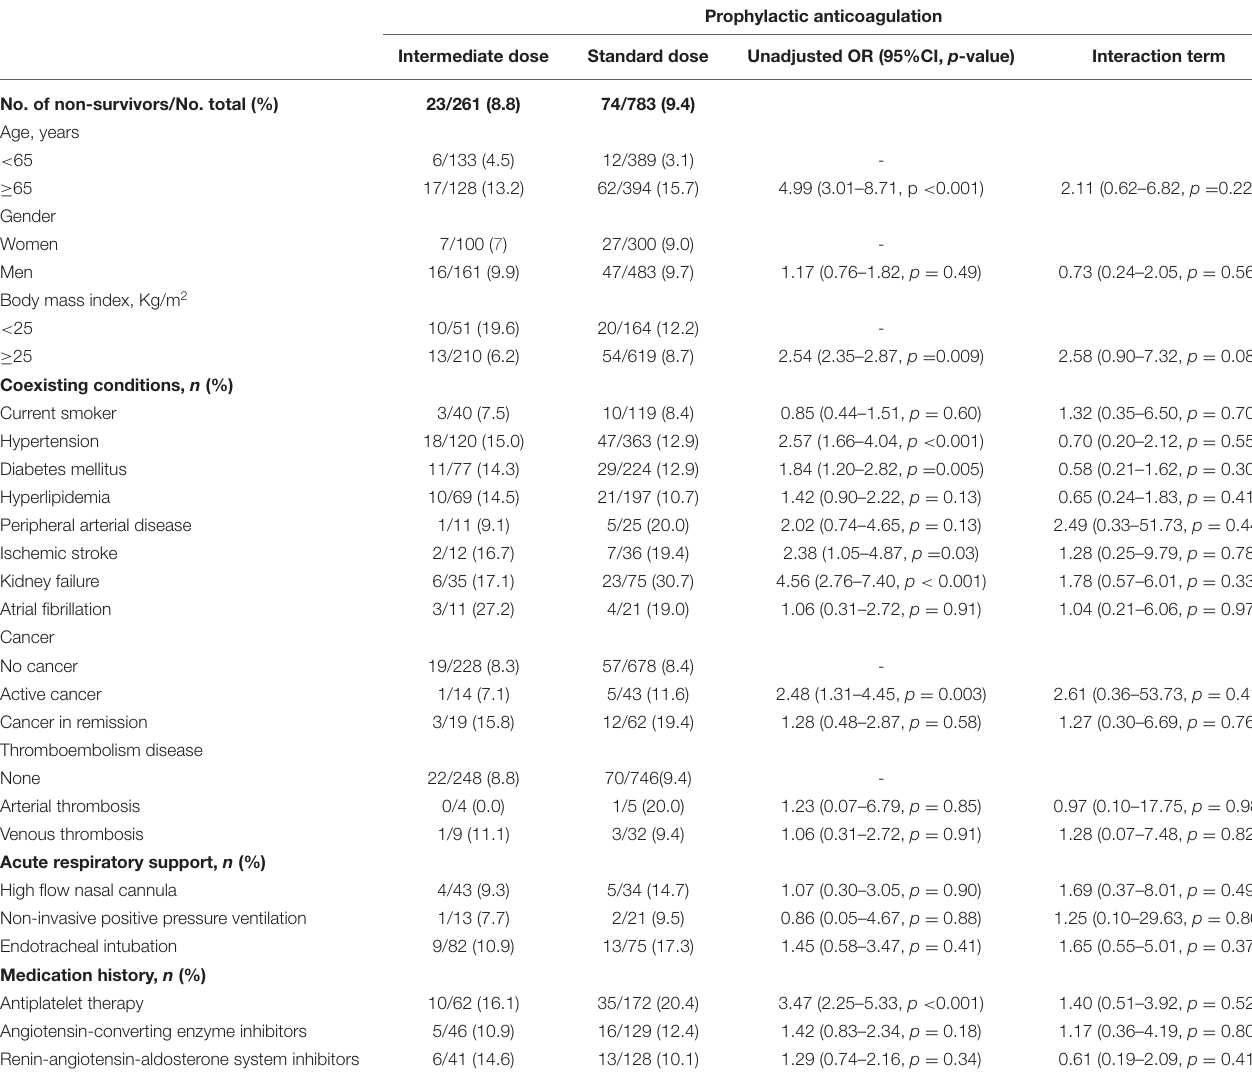
TABLE 2 | Subgroup analysis for COVID-19 in-hospital mortality: the study of the interaction between the treatment group and each of the assessed variables for in-hospital mortality. Prophylactic anticoagulation Intermediate dose Standard dose Unadjusted OR (95%CI, p -value) Interaction